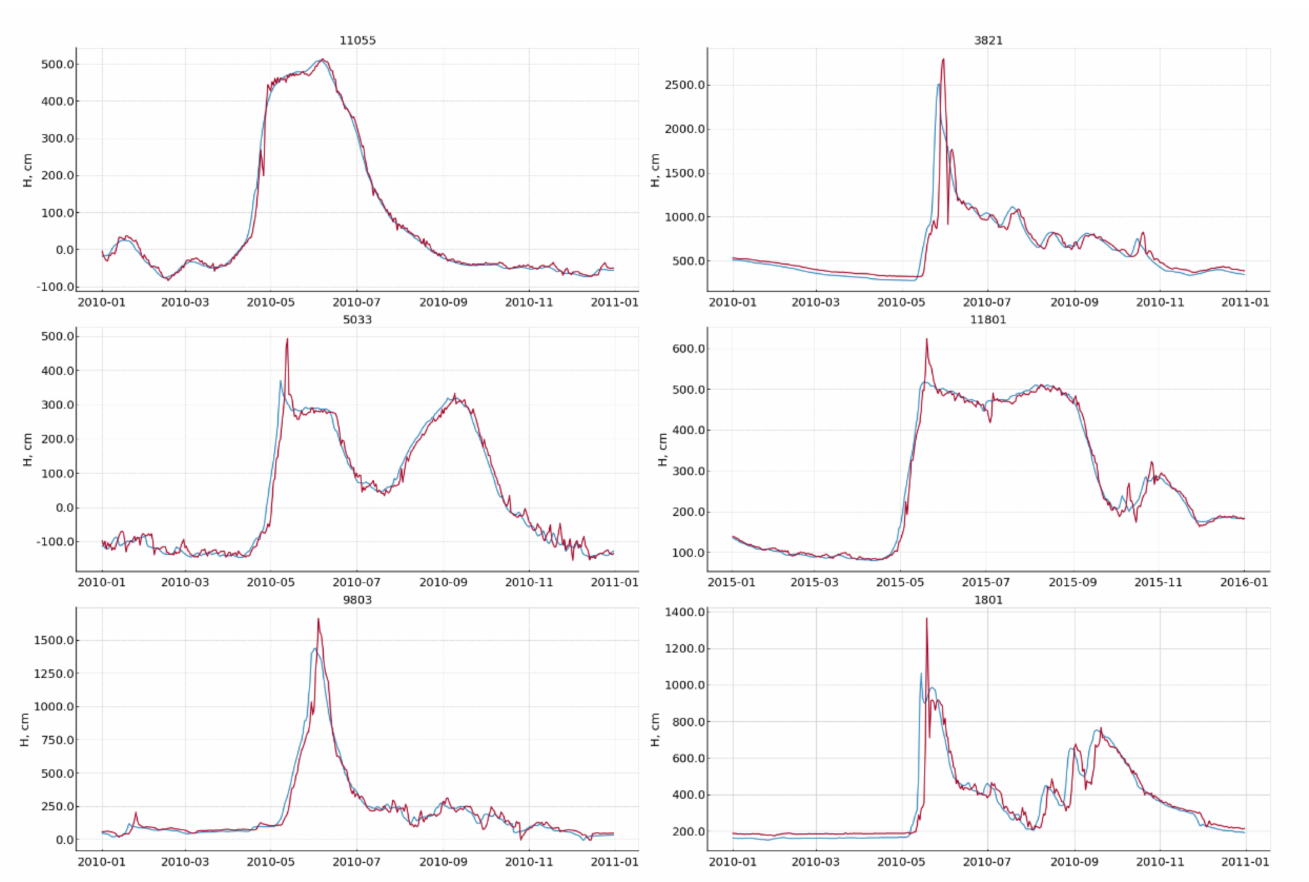
Figure 2. Observed (blue) and forecasted with a lead time ∆ t = 5 days (red) hydrographs at major gauging stations (listed in Table 2) in 2010–2011.